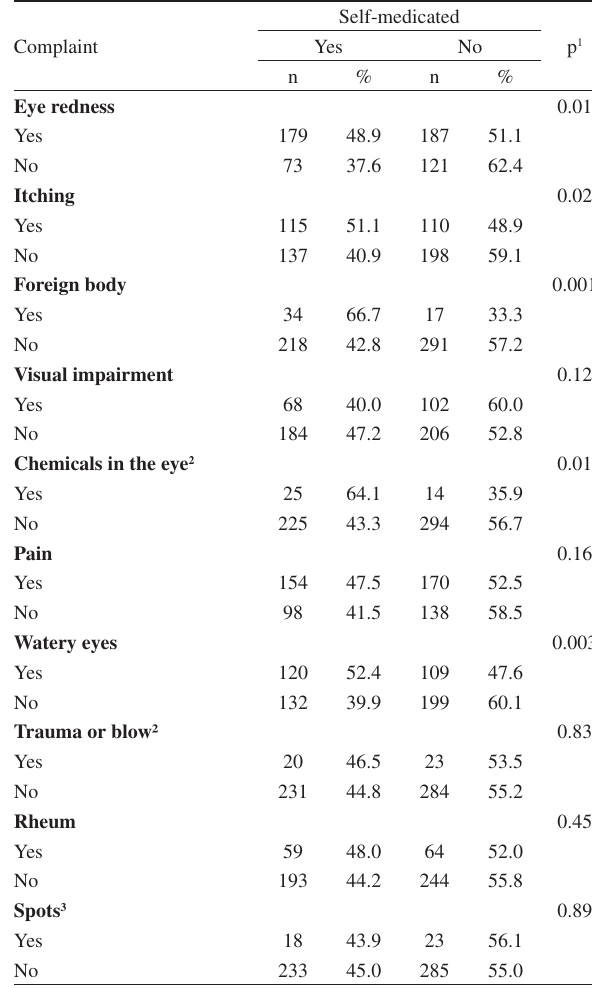
Characteristics